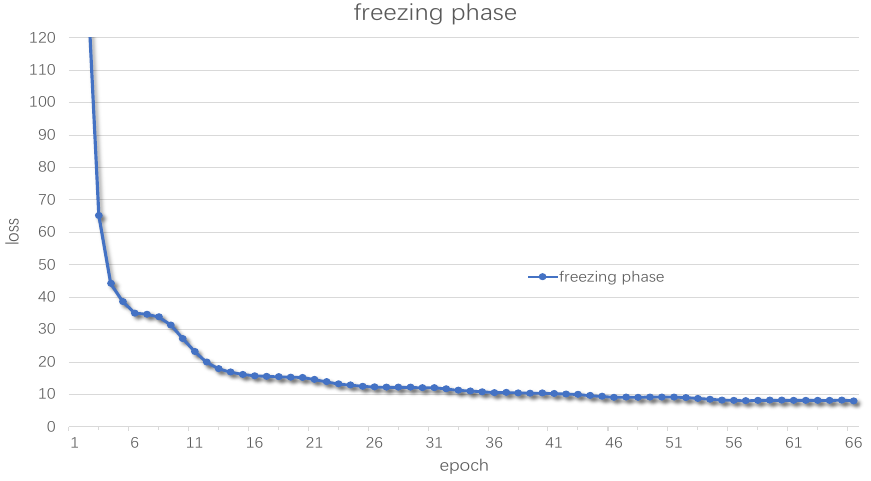
Figure 7. Loss change in freezing phase.